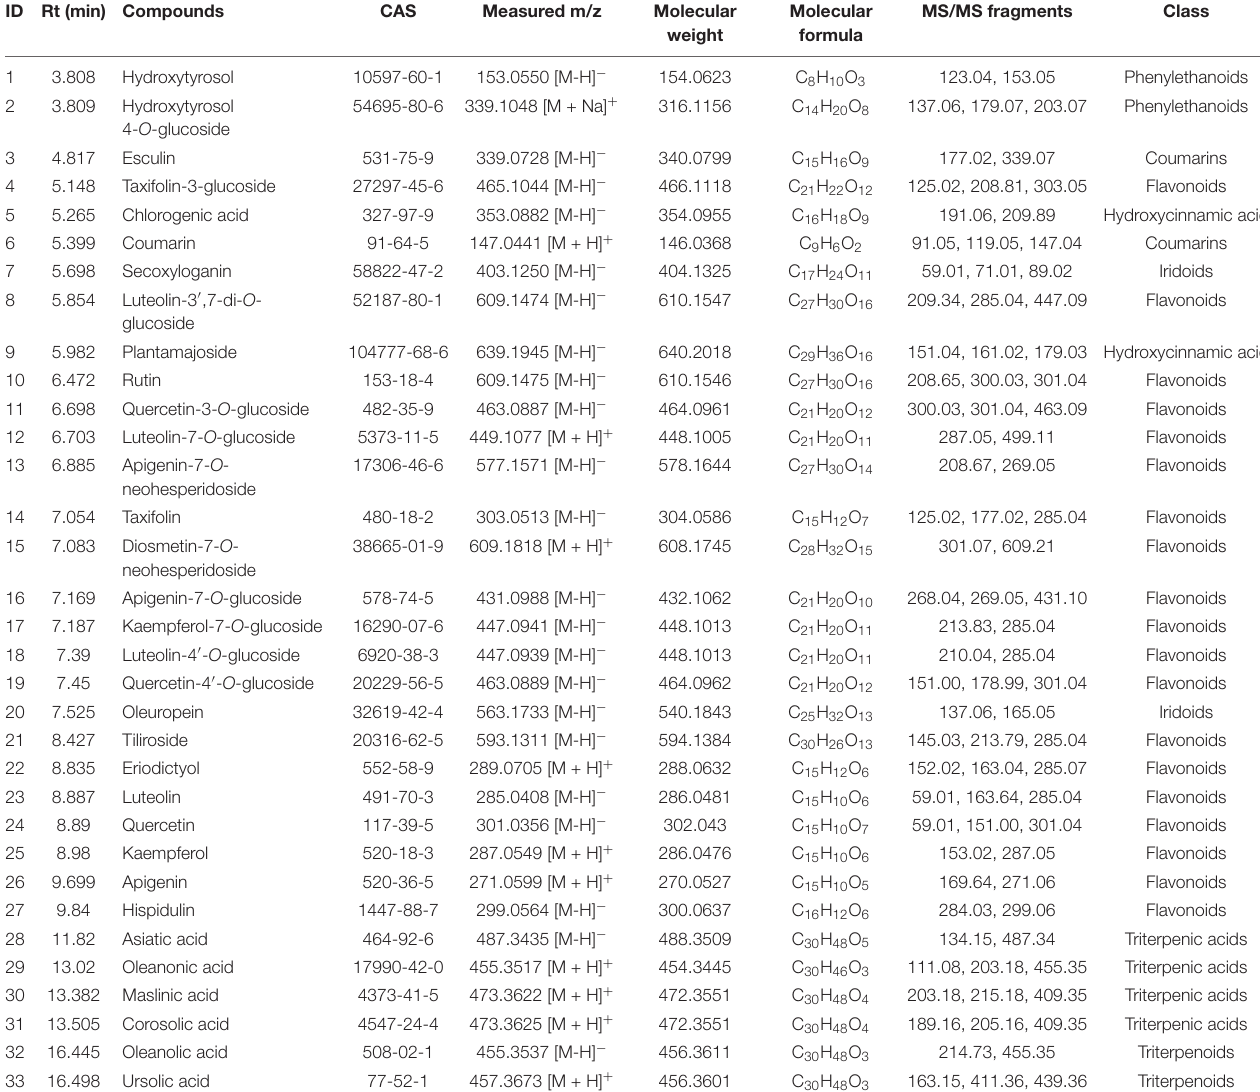
TABLE 2 | Phytochemical compounds identified in olive leaves via UPLC-Q-Exactive Orbitrap-MS. ID Rt (min)